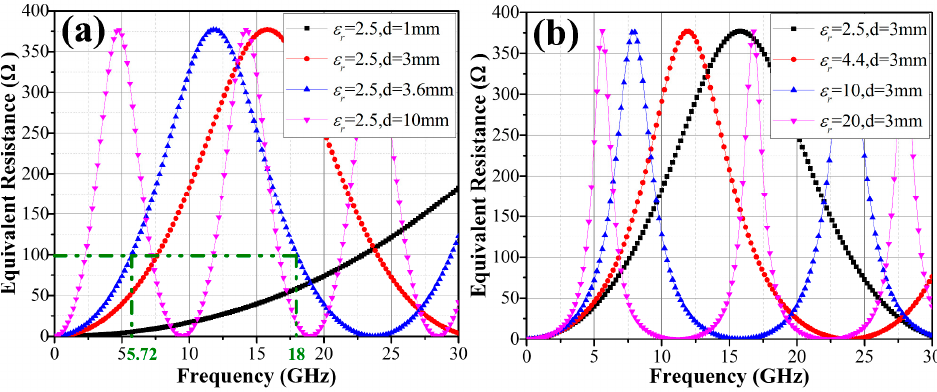
Figure 3. ( a ) The R - f curves with fixed relative permittivity ε r = 2.5 but different thickness d ; ( b ) the R - f curves with fixed thickness d = 3 mm but different relative permittivity ε r